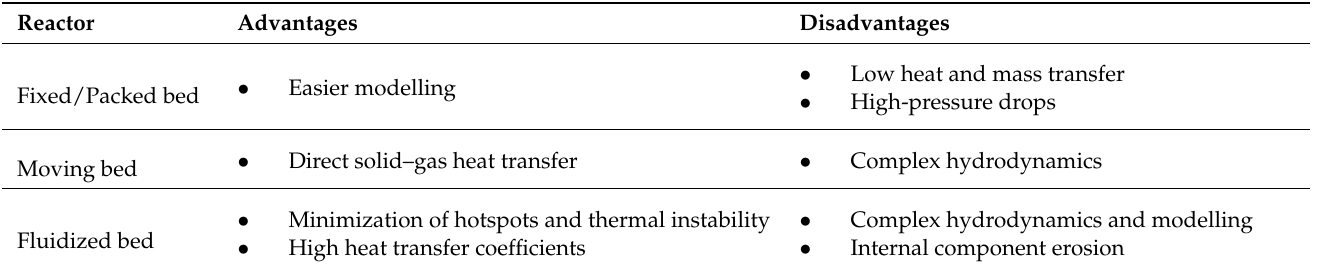
Table 6. Comparison of fixed-, moving-, and fluidized-bed reactors [24].